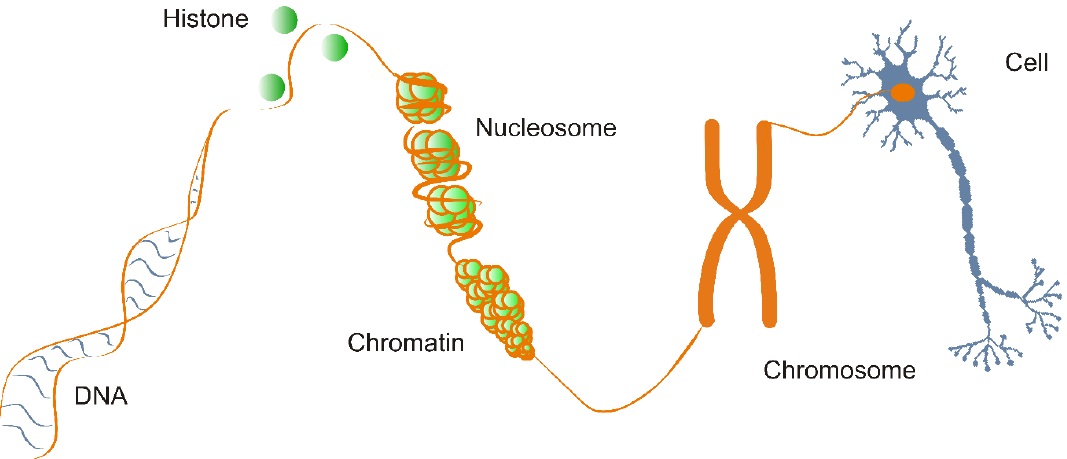
Figure 1. Structural background of the epigenome with a schematic illustration of major organizational levels. A neuron was selected to represent the cellular level as “precise epigenetic regulation may be critical for neuronal homeostasis” [21].